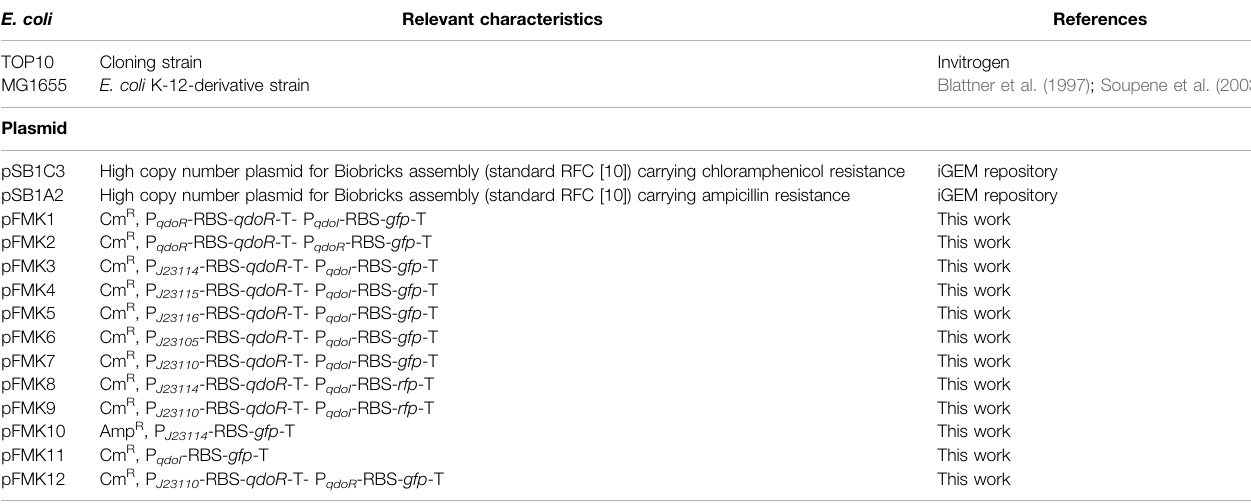
TABLE 1 | Plasmids constructed and used in this